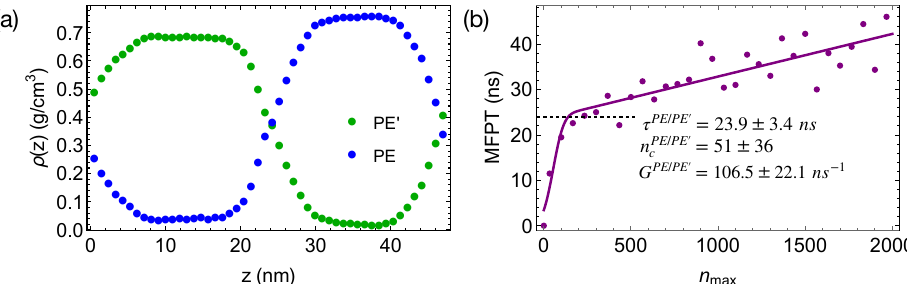
Figure 9. ( a ) Density profiles of phase-separated PE and PE’ oligomers at 420 K; ( b ) MFPT for the largest crystalline nucleus of PE to reach size n max in PE/PE’ blends. Fit to classical nucleation theory